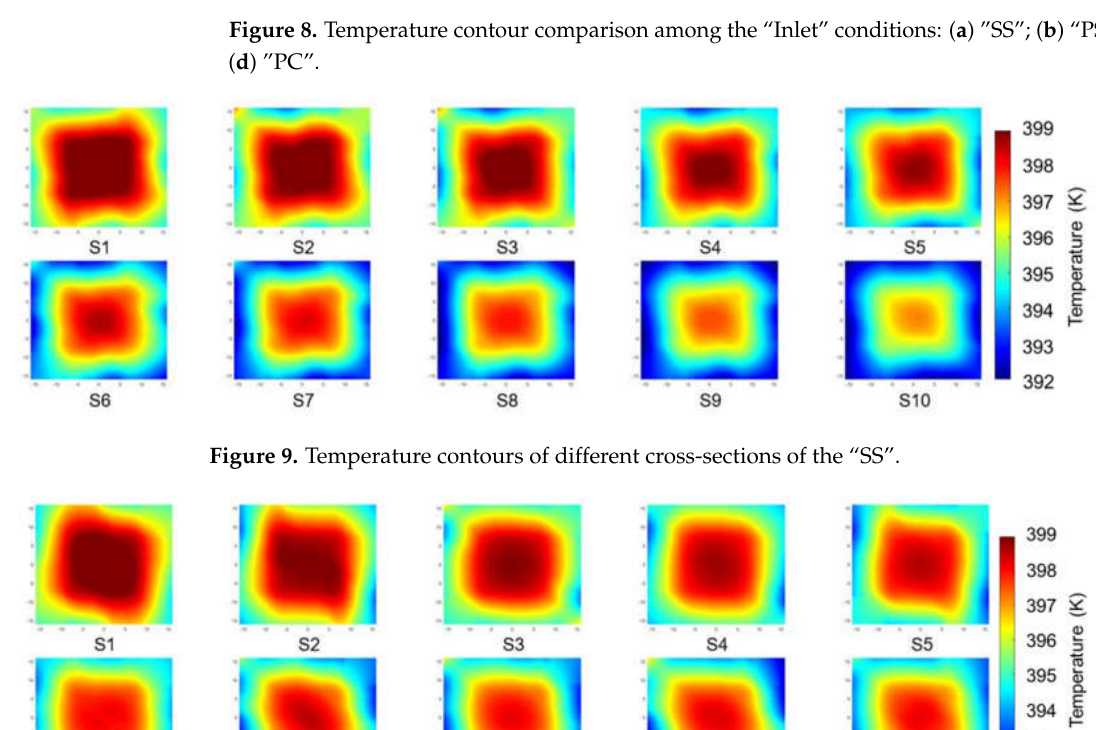
Figure 8. Temperature contour comparison among the “Inlet” conditions: ( a ) ”SS”; ( b ) “PS”; ( c ) “SC”; ( d ) ”PC”.